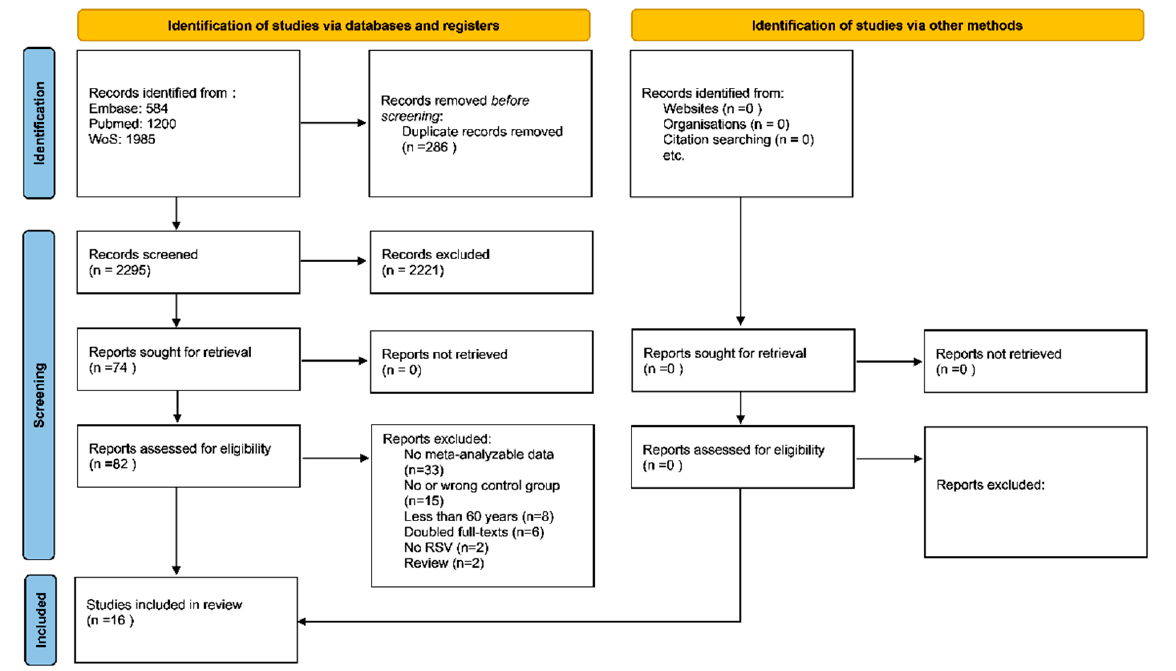
Figure 1. PRISMA flow-chart. Legend: n = number.